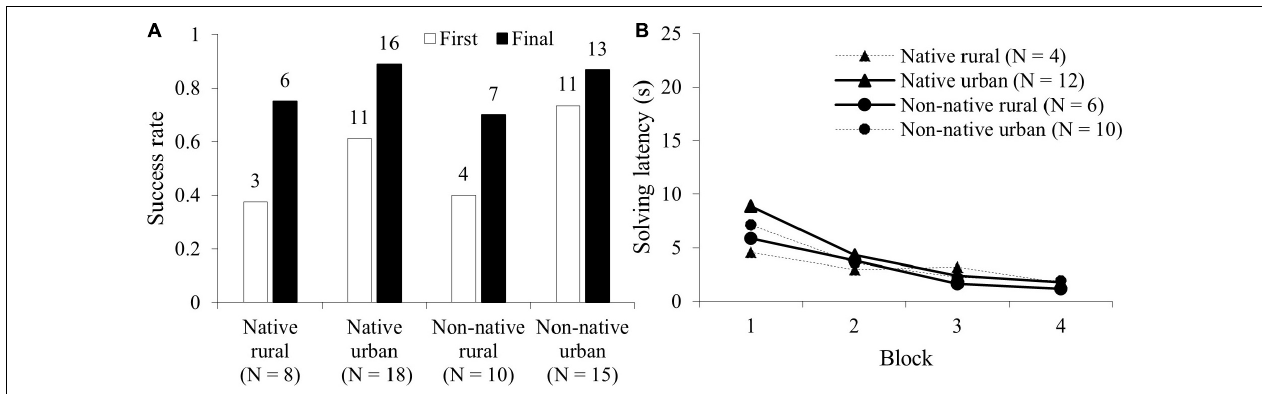
FIGURE 2 | Comparisons of the performance in the easy problem among the four squirrel groups (native rural, native urban, non-native rural, and non-native urban group). (A) Success rate (the number of innovators that lifted a lid) on the first visit (First) and in the subsequent visit (Final), and (B) mean total solving latency to obtain a success (in seconds) across 4 blocks of 5 successes (20